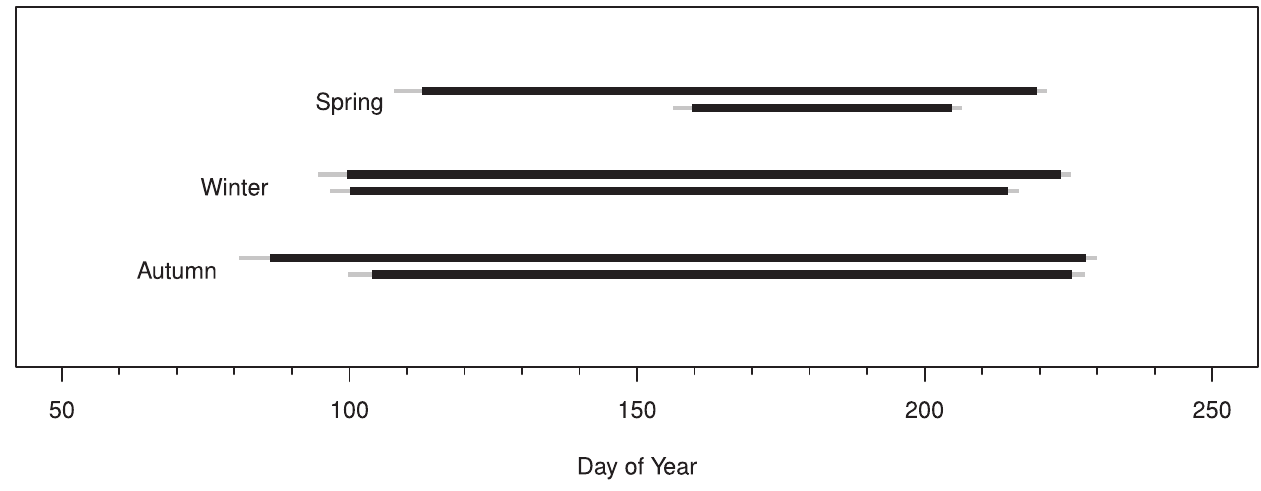
Figure 2. Critical climate periods for uplands (top black bar in pair) and lowlands (lower black bar in pair) for autumn-, winter-, and spring-burned plots. Gray bars represent standard errors on start and end dates for the 20 critical climate periods that explain the most variation in grass productivity.